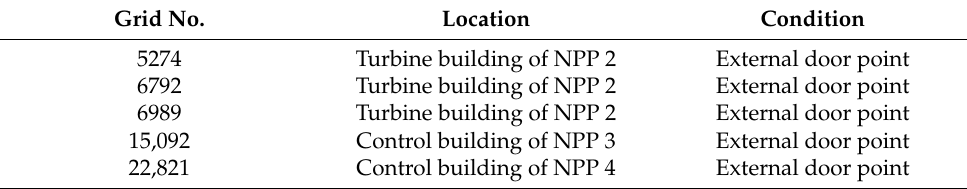
Figure 3. Inflow boundary points for internal analysis (Google Maps image). Table 3. Inflow boundary